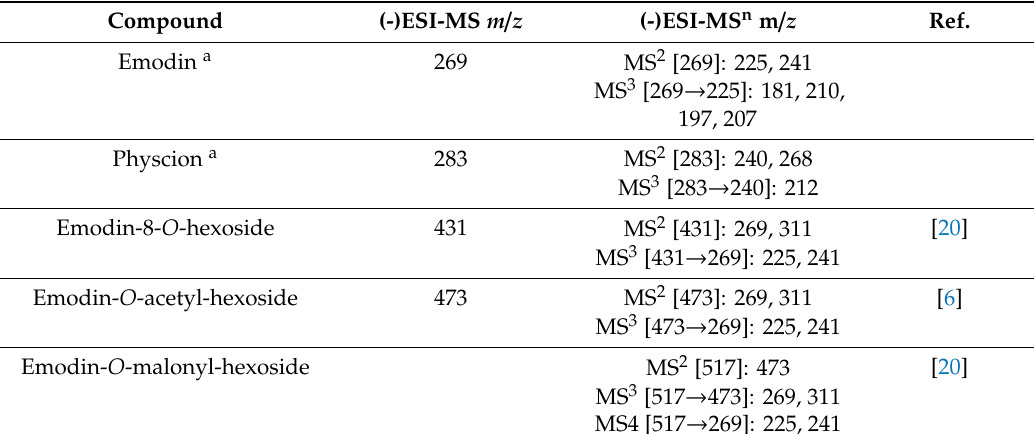
Table 2. Anthraquinones tentatively identified in Japanese knotweed rhizomes by HPTLC- MS / MS.